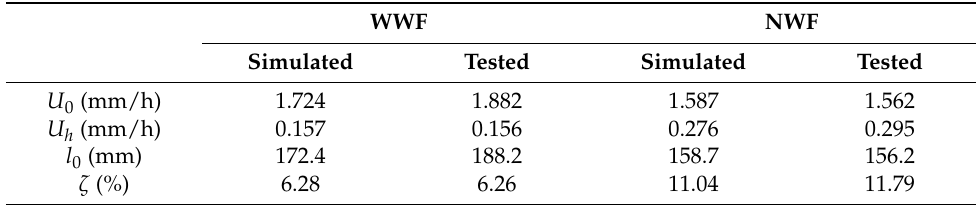
Table 4. Frost heave test and simulation results.